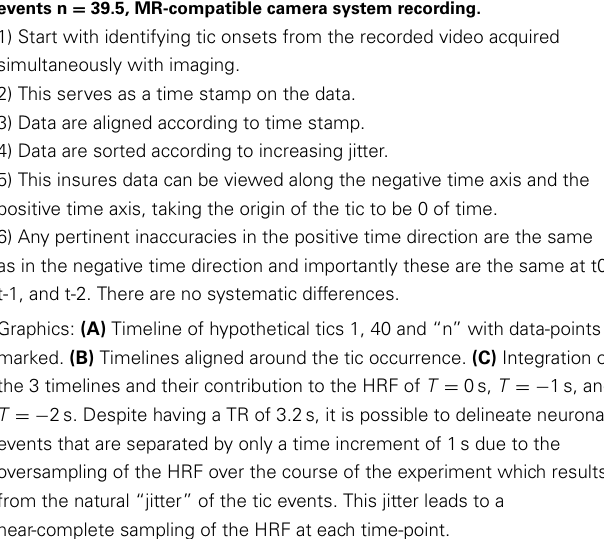
Supplementary Figure 1 | Framework of the study: event related design, tics occur at random (so onsets are well jittered), on average number of events n = 39.5, MR-compatible camera system recording.